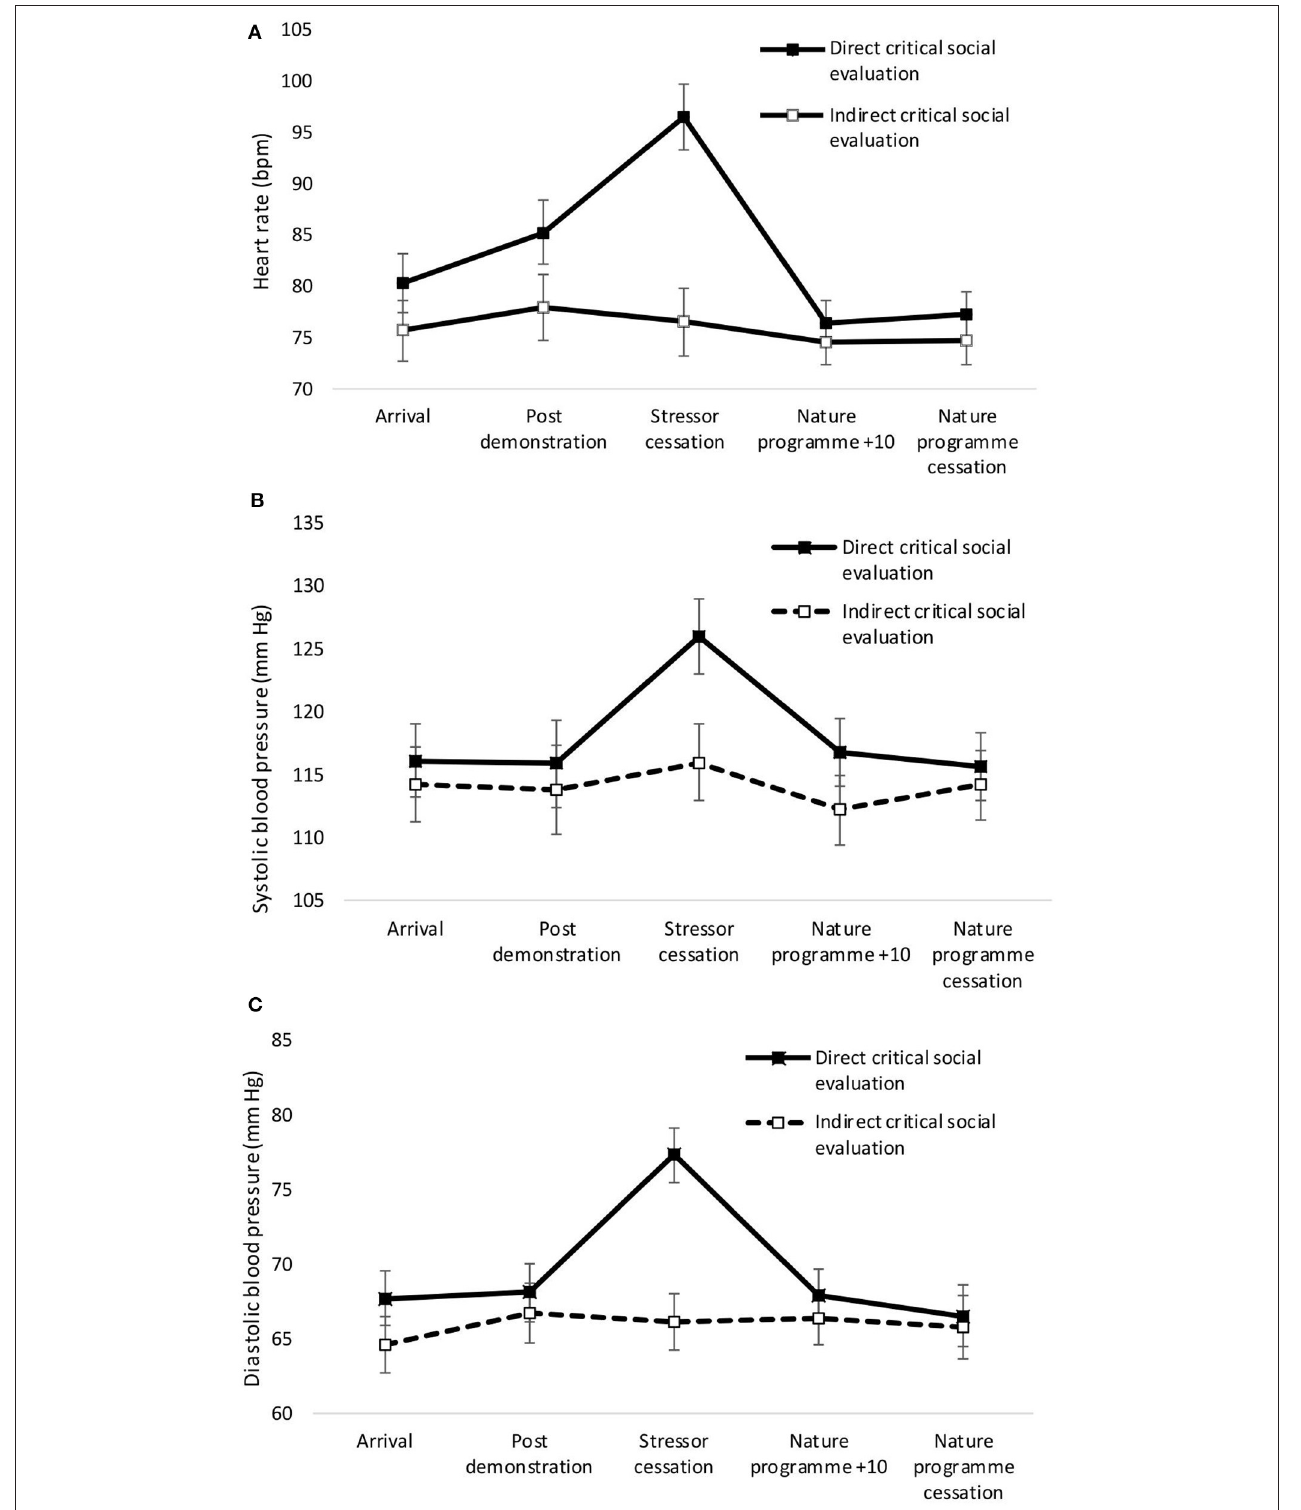
FIGURE 1 | Mean (and SE) heart rate (A) , systolic (B) , and diastolic (C) blood pressure for direct and indirect social evaluation conditions.